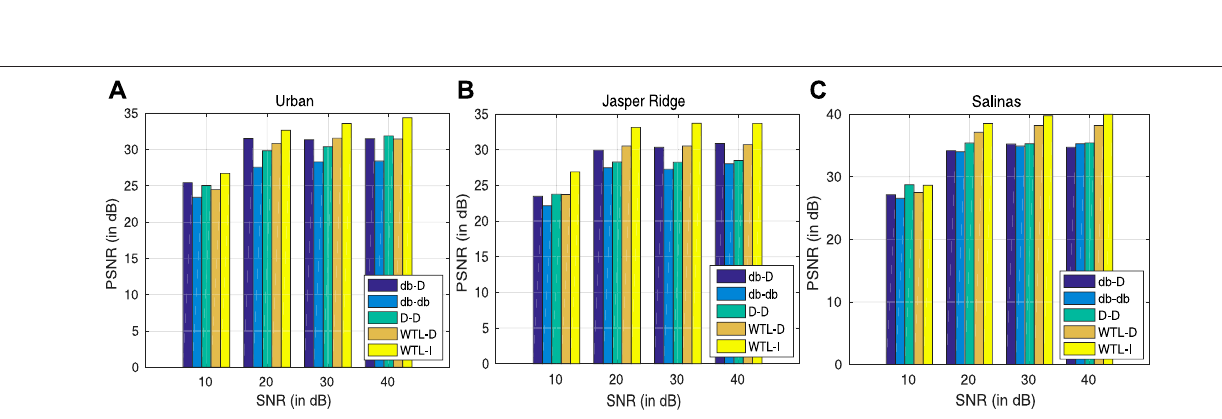
FIGURE 9 | Reconstruction of 20th band of data set Salinas with different sparsifying basis at 20 db SNR and 5 % SR. (A) Original band, (B) db-db, (C) db-D, (D) D-D, (E) WTL-D, and (F) WTL-I.